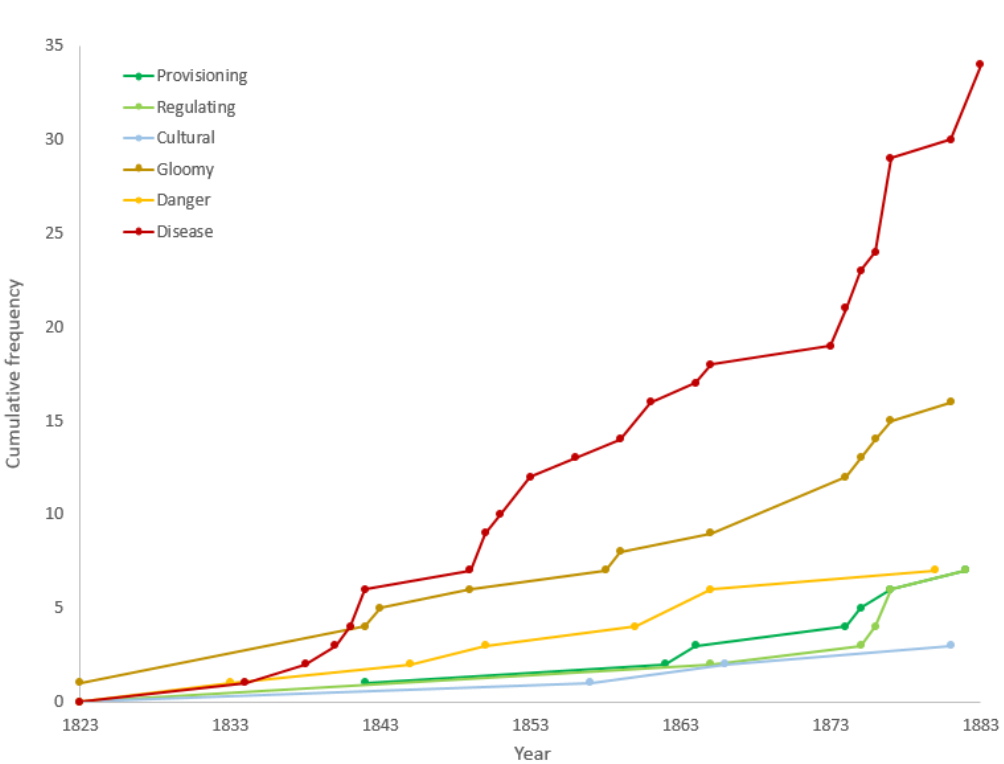
Figure 1. Changes in the reporting of mangrove ecosystem services and disservices between 1823 and 1883.